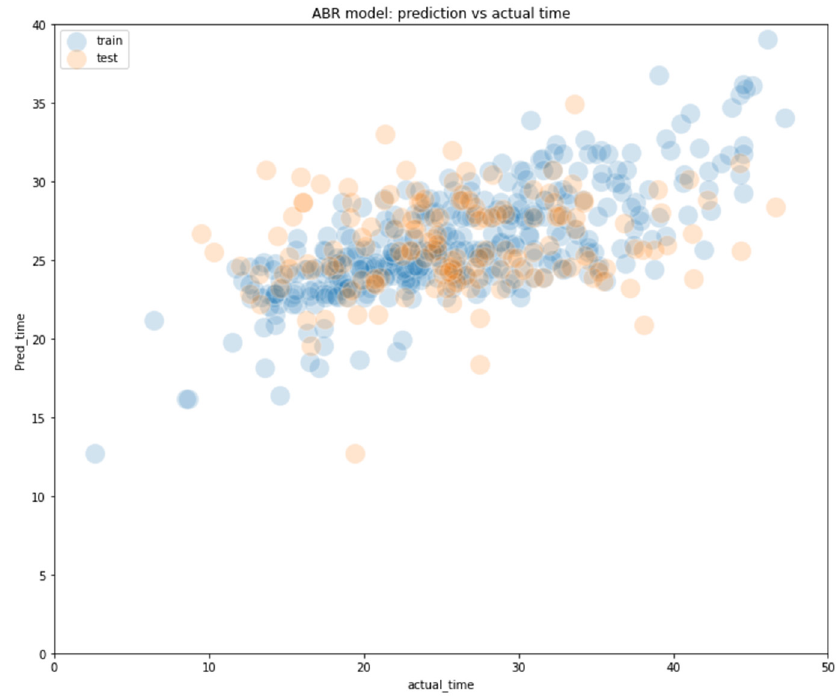
Figure 5. Scatterplots comparing actual treatment time vs predicted treatment time for the AdaBoost model.